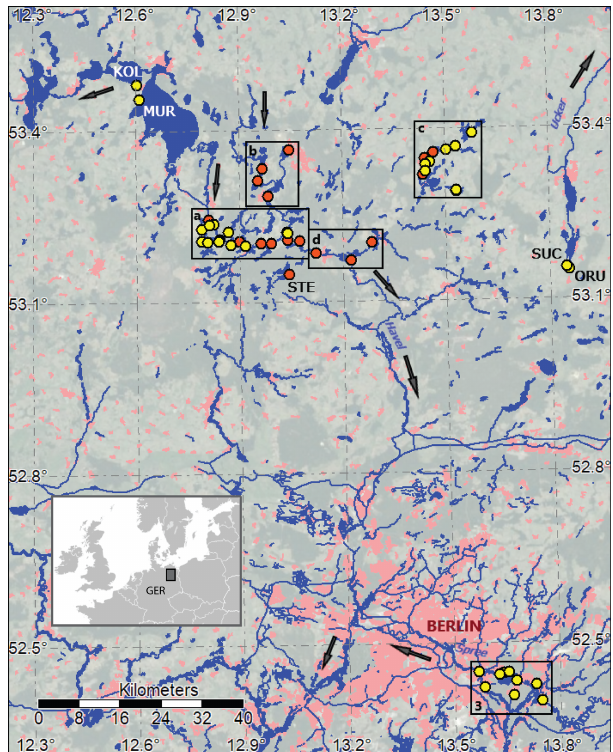
Figure 1. Sampling locations at lake shores (yellow) and buoys (red). Arrows indicate major flow directions of rivers. Black boxes refer to detailed maps in Figs. 2a–d and 3. The inset map indicates the location of the study area in Europe. Underlying map © Google Maps